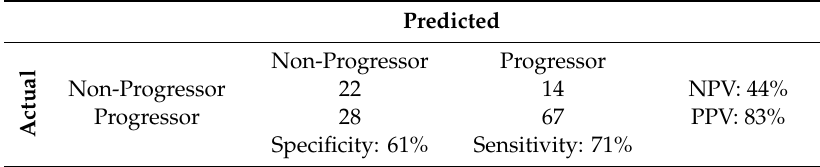
Table 3. A confusion matrix created on D2 using the RF model using an operating point threshold of 0.69. The positive predictive value (PPV), negative predictive value (NPV), sensitivity and specificity was also calculated on D2 using the same operating point.